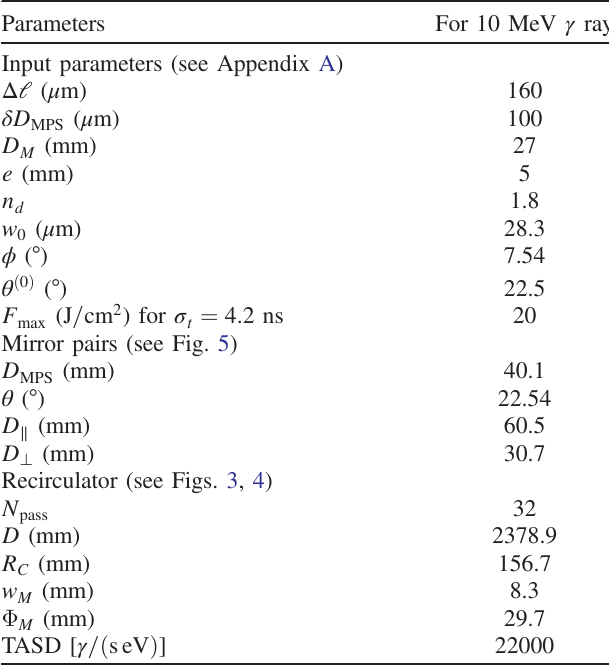
TABLE II. Summary table of the recirculator ’ s parameters obtained after optimization with the specified input para- meters for ELI-NP-GBS ’ s specifications (see Appendix A for